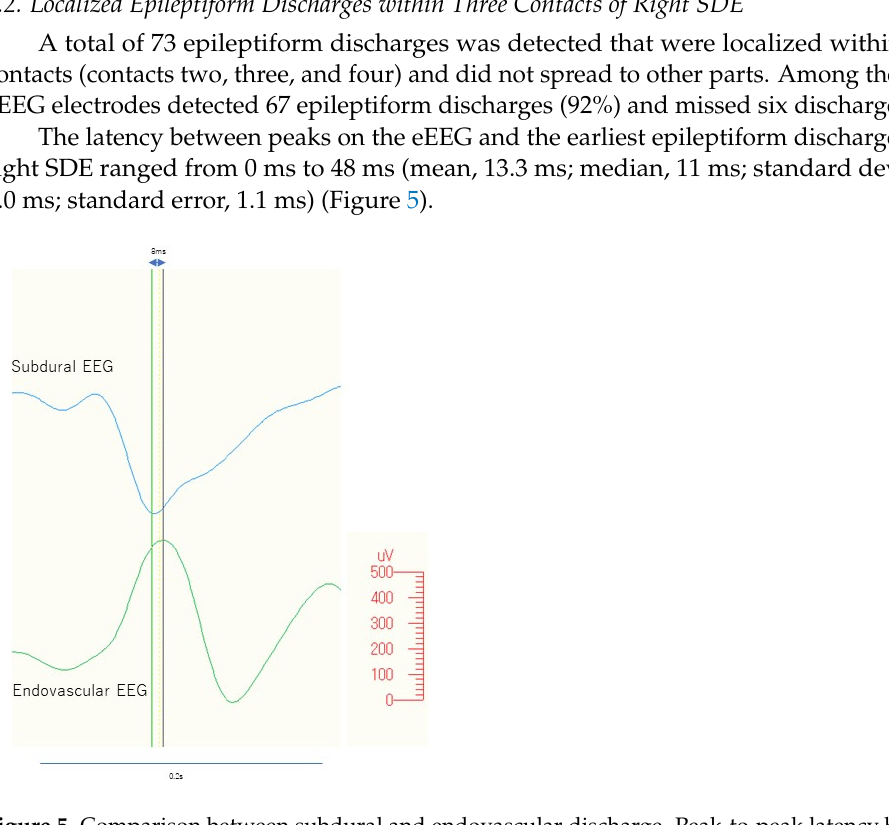
Figure 5. Comparison between subdural and endovascular discharge. Peak-to-peak latency between the endovascular and subdural discharges from one of the representative discharges is shown at 8 ms.